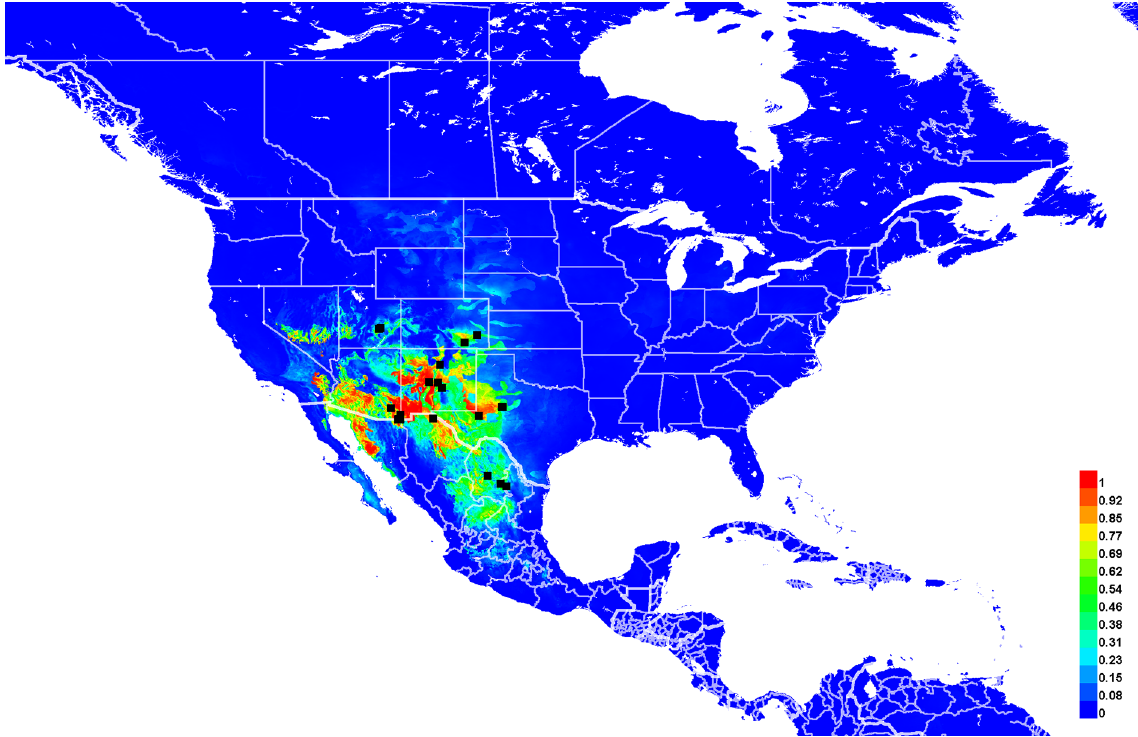
Fig. 54. Georeferenced collection records of Lasioglossum ( D. ) lilianae sp. nov. (black squares) and predicted distribution by maximum entropy ecological niche modeling in Maxent (colour shading). Warmer colours indicate higher cloglog probability of occurrence. One doubtful record from Tulare County, California was left out of the